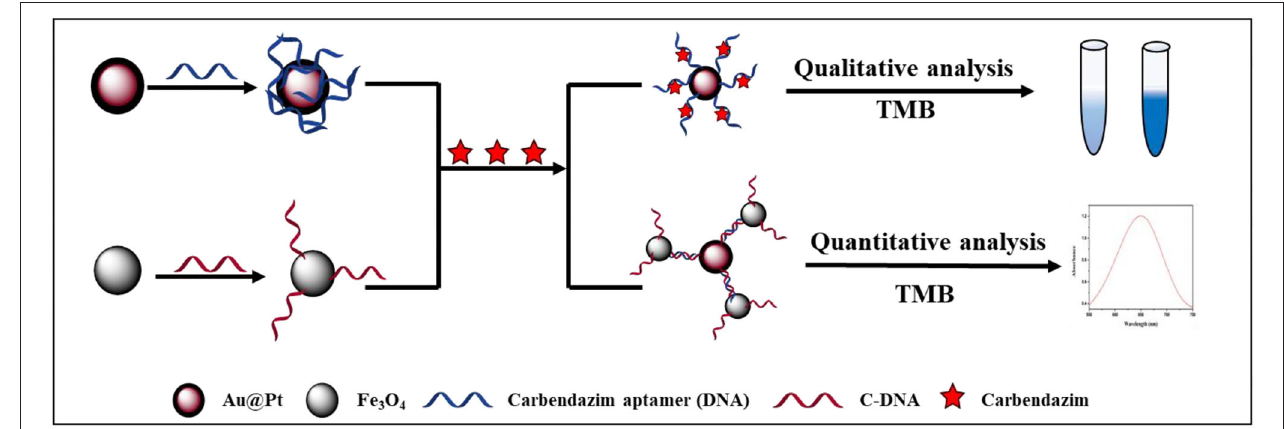
FIGURE 1 | Schematic illustration of a competitive assay based on dual-mode Au@Pt-DNA biosensors for the sensitive determination of CBZ fungicide.